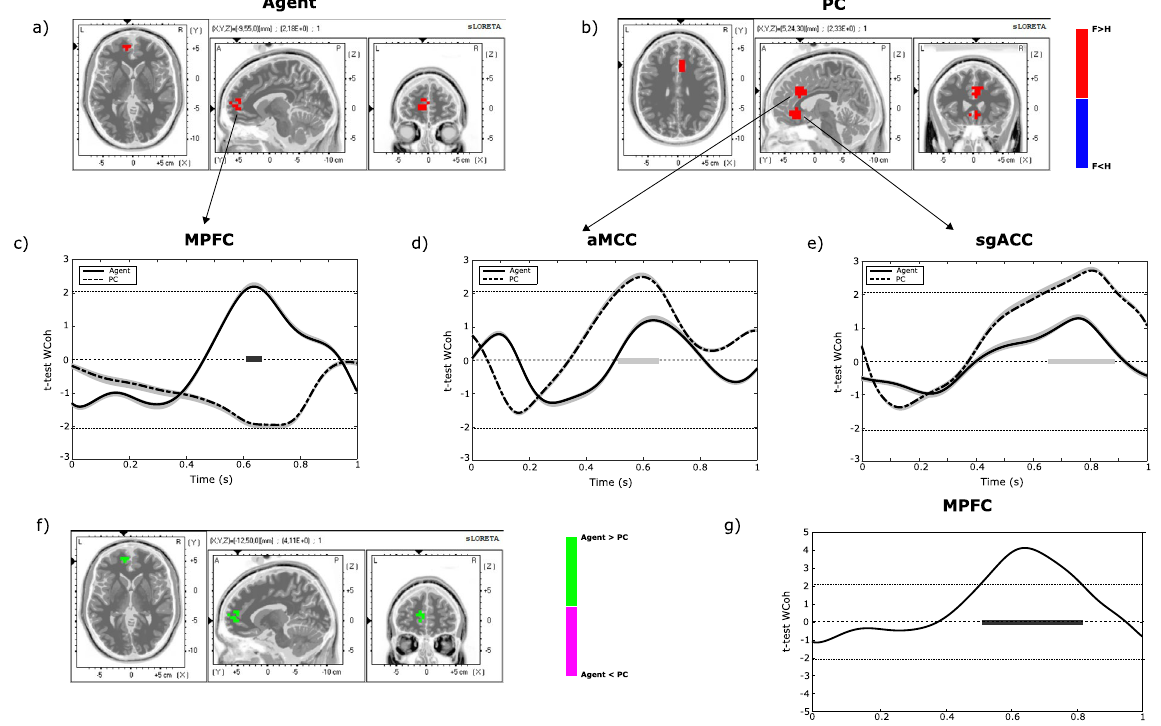
Figure 3. ( a , b ) Grand Average 3D statistical maps over LPP peak latency (600–700 ms). The colorbar represents the t-value obtained comparing receiver–observer wavelet coherence in fair and hyperunfair conditions (paired t-test, alpha = 0.05), in the Agent ( a ) and PC ( b ) conditions. Only statistically significant values are reported. ( c – e ) Diagrams reporting the t-values and the related confidence interval for Agent and PC conditions obtained at MPFC ( c ), aMCC ( d ) and sgACC ( e ) locations, comparing receiver–observer wavelet coherence in fair and hyperunfair conditions. The solid dark and light grey lines over the x-axis indicate the temporal interval in which the wavelet coherence is statistically different between fair and hyperunfair (paired t-test, alpha = 0.05, validated by means of Guthrie-Buchwald method) in Agent and PC conditions, respectively. ( f ) Grand Average 3D statistical maps over LPP peak latency (600–700 ms). The colormap represents the t-value obtained comparing the receiver–observer wavelet coherence in Agent and PC conditions (paired t-test, alpha = 0.05). Only statistically significant values are reported. ( g ) Diagram reporting t-values and the related confidence interval obtained at MPFC location comparing the receiver–observer wavelet coherence in Agent and PC conditions. The dark grey line over the x-axis indicates the temporal interval in which wavelet coherence is statistically different between Agent and PC conditions (paired t-test, alpha = 0.05, validated by means of Guthrie–Buchwald